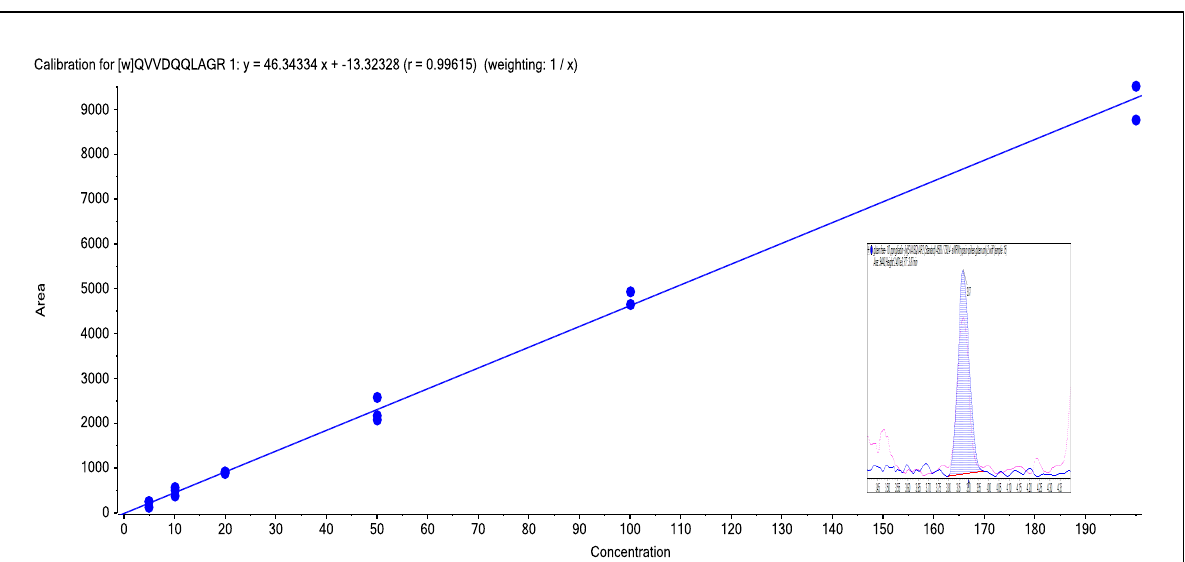
Figure 9. The calibration line obtained from the spiking of gliadin into gluten-free wheat from the range of 5–200 ppm for wheat peptide 3. Inlayed in the calibration line is the chromatogram for the 10 ppm spike of gliadin into gluten-free flour. The calibration line was a linear 1/ x fit with r =